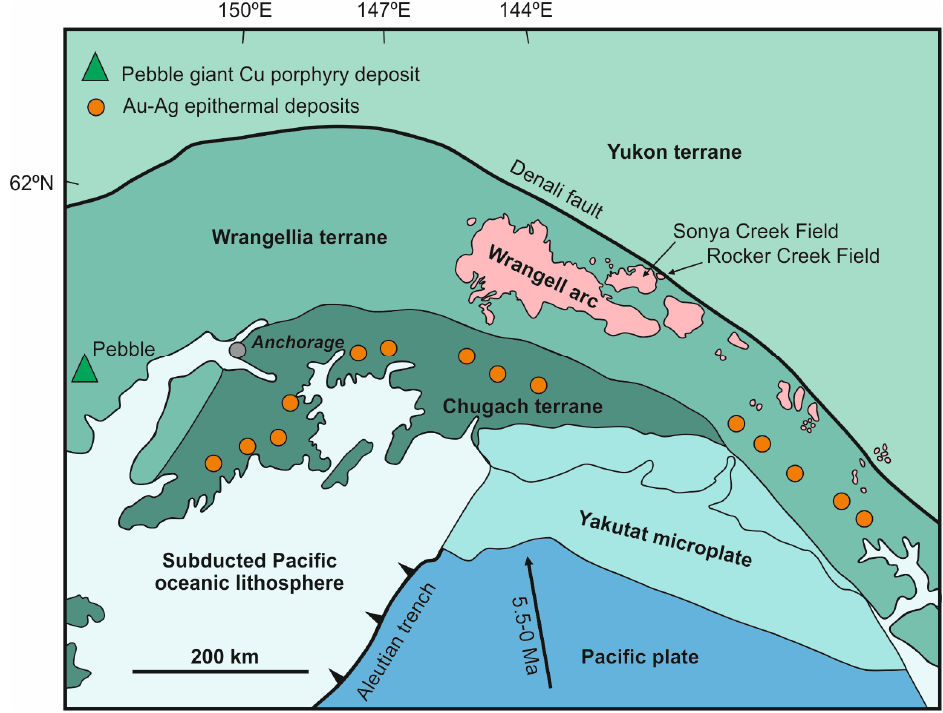
Figure 17. Simplified tectonic map of Southeastern Alaska showing location of principal adakite volcanic centers (23.3–18.6 Ma Sonya Creek and 26.3 Ma Rocker Creek Fields) and Cu porphyry (green triangle) and Au–Ag epithermal (orange circles) deposits. Location of main accreted terranes Yukon, Wrangellia and Chugach), subduction zones (Aleutian trench) and subducted plates (Pacific and Yakutat) are after [241]. Continental margin of southern Alaska, especially its Mesozoic to Early Tertiary ac- cretionary prism, contains multiple lode-type gold deposits and showings (Figure 17; [243]). Gold-bearing quartz veins were emplaced in large-scale brittle structures after the regional deformation and metamorphism of clastic sediments in the Valdez and Orca Groups, the McHugh Complex and correlative units along the southern Alaska continen- tal margin [243]. Regional deformation and metamorphism were accompanied by the em- placement of granitic magmas with distinctive adakitic signature (Sr = 367–692 ppm; Y = 3.53–4.27 ppm; Yb = 0.32–0.38 ppm; Sr/Y = 86–178; Table 3 in [244]). Although most of